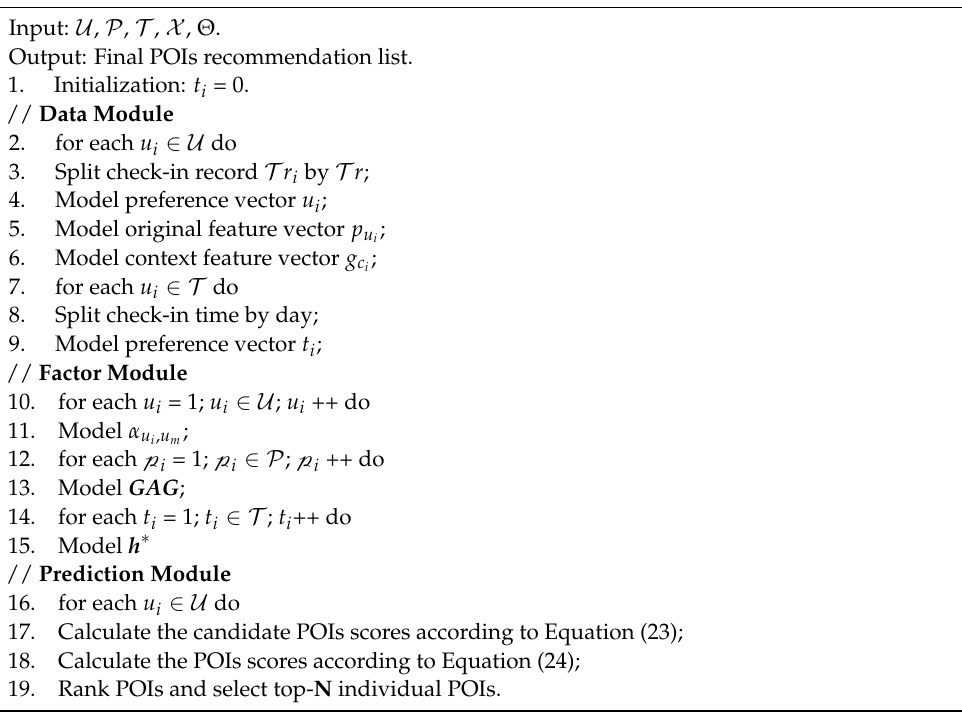
Algorithm 1: The Procedure of